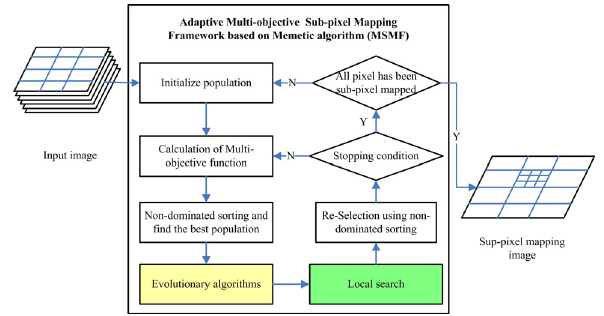
Figure 3 Adaptive multi-objective sub-pixel mapping framewok based on memetic algorithm